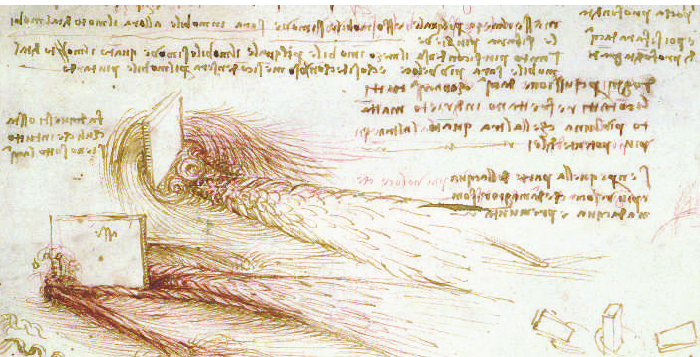
Figure 1. Turbulence generated by inserting differently shaped obstacles into a stream of water. Drawing by Leonardo da Vinci, 1509, from Codex Windsor, Royal Collection in Windsor Castle,